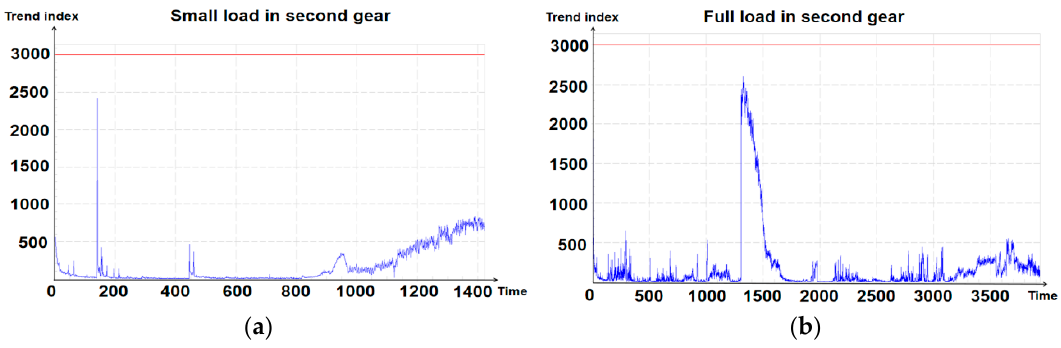
Figure 8. Small load ( a ) and full load ( b ) in second gear.